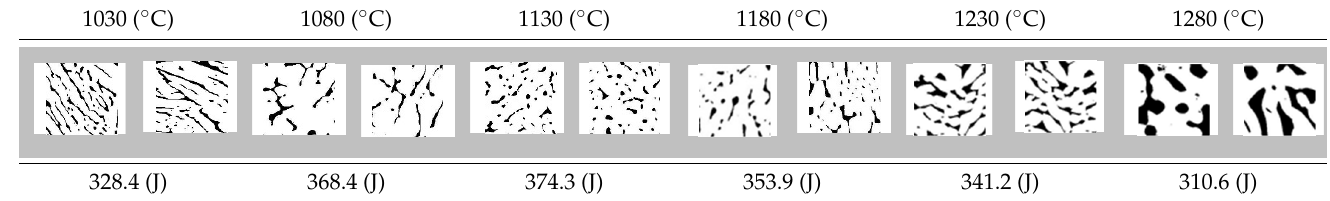
Table 3. Heat treatment temperature ( ◦ C), micrograph images, and impact energy (J). Table 3. Heat treatment temperature (°C), micrograph images, and impact energy (J). Table 3. Heat treatment temperature (°C), micrograph images, and impact energy (J). Table 3. Heat treatment temperature (°C), micrograph images, and impact energy (J). Table 3. Heat treatment temperature (°C), micrograph images, and impact energy (J). Table 3. Heat treatment temperature (°C), micrograph images, and impact energy (J). Table 3. Heat treatment temperature (°C), micrograph images, and impact energy (J). Table 3. Heat treatment temperature (°C), micrograph images, and impact energy (J). Table 3. Heat treatment temperature (°C), micrograph images, and impact energy (J). Table 3. Heat treatment temperature (°C), micrograph images, and impact energy Table 3. Heat treatment temperature (°C), micrograph images, and impact energy (J). Table 3. Heat treatment temperature (°C), micrograph images, and impact energy (J). Table 3. Heat treatment temperature (°C), micrograph images, and impact energy (J).